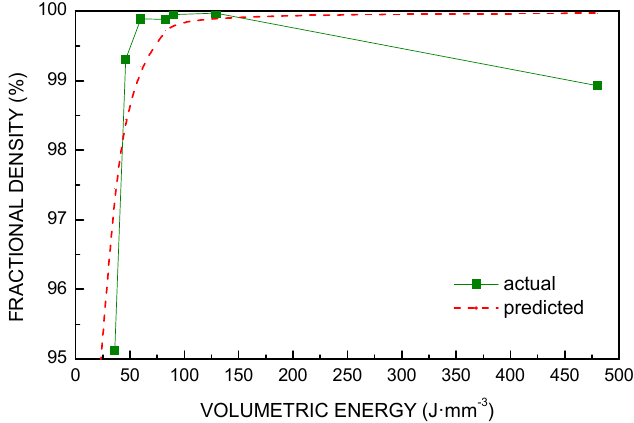
Figure 9. Actual vs predicted fractional density as a function of VED .